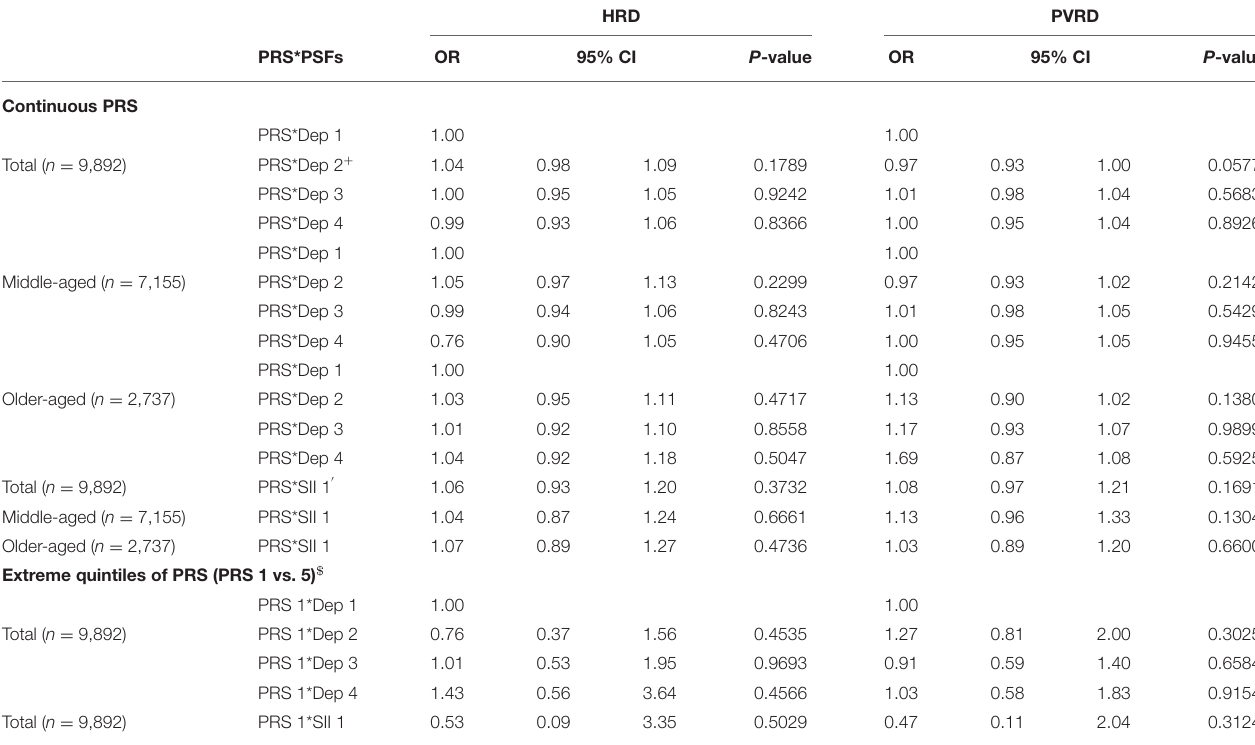
TABLE 5 | Interaction associations between PRS and PSFs on CVDs. HRD PVRD PRS*PSFs OR 95% CI P -value OR 95% CI P